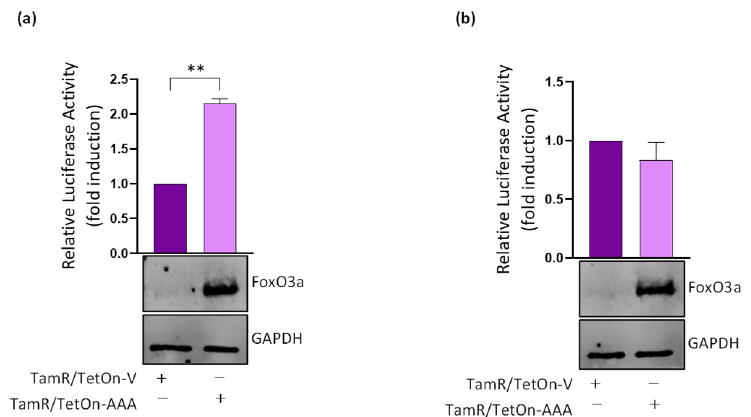
Figure A3. FoxO3a transactivates the human integrin α 5 promoter. TamR/TetOn-AAA cells were